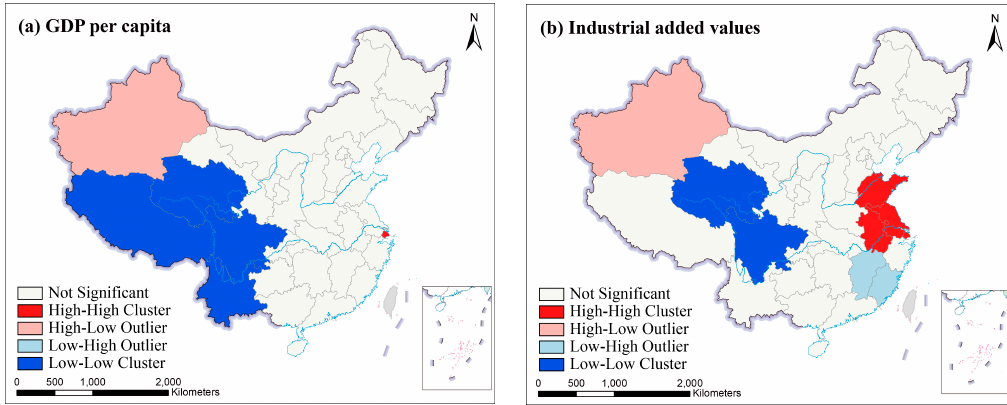
Figure 11. Global Bivariate Moran's I for province-level between PM 2.5 and socioeconomic factors in Mainland China, 1998–2016. ( a ) Global Bivariate Moran's I between PM 2.5 and GDPP. ( b )